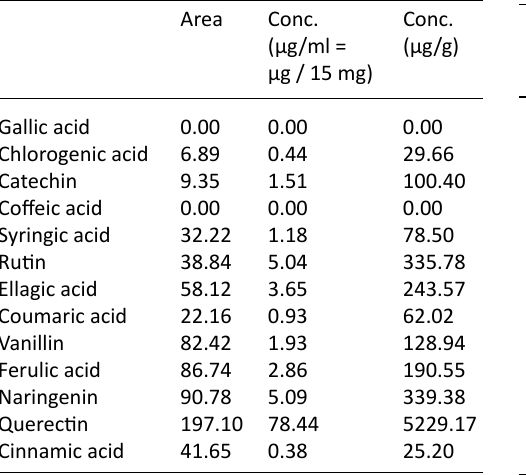
Table 5. Commiphora myrrh resin petroleum ether Table 6. Commiphora myrrh resin chloroform extract extract (Conc. 15 mg/ml) (Conc. 15 mg/ml) Commiphora myrrh Petroleum ether (Conc. 15 mg/ml) Commiphora myrrh Chloroform (Conc. 15 mg/ml) Area Conc. Conc. µg / 15 mg) Gallic acid